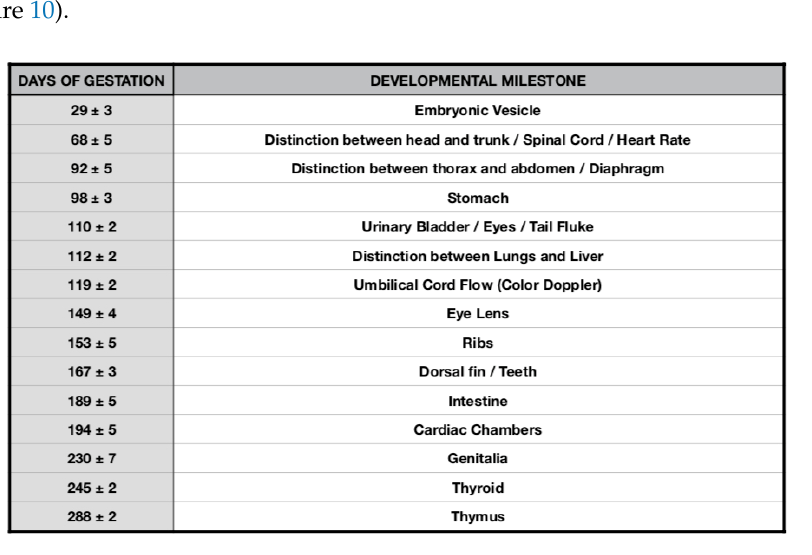
Figure 10. Bottlenose dolphin ( Tursiops truncatus ) organogenesis timeline table.